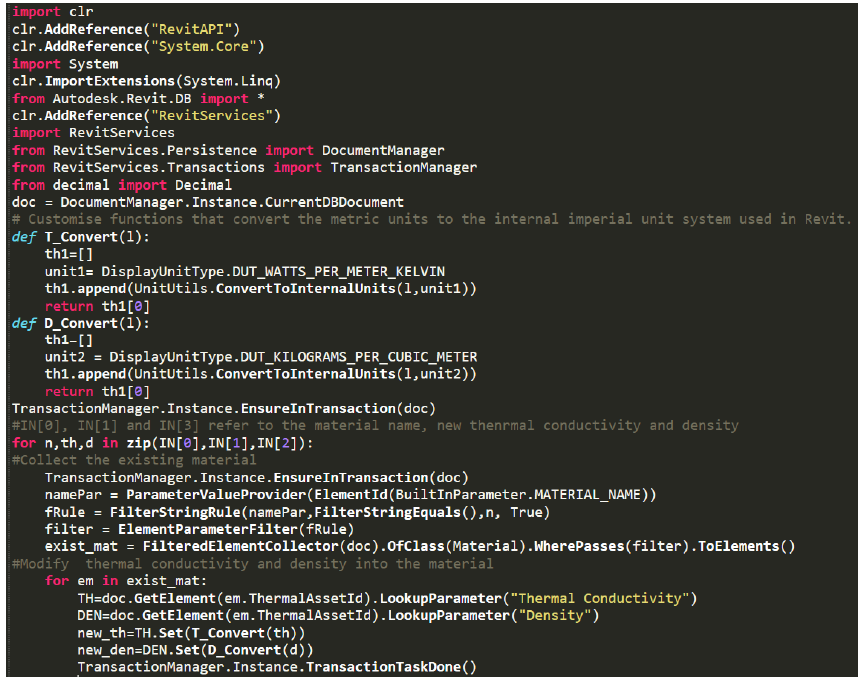
Figure A2. Dynamo Python Script to Update Insulation Material Thermal Properties.